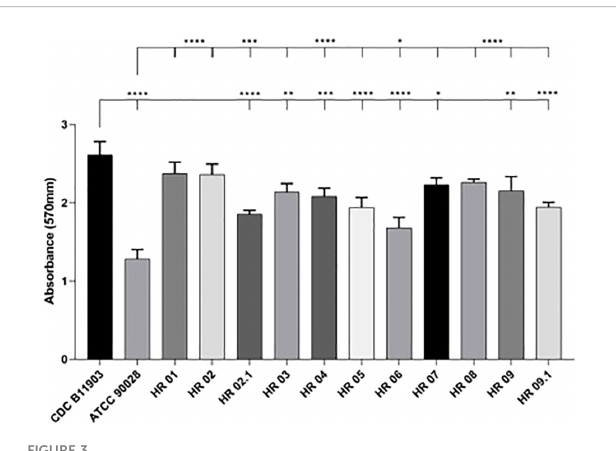
FIGURE 3 Bio fi lm formation capacity on the polystyrene surface of clinical isolates of C. auris after 24 h. One-way analysis of variance with multiple comparisons by Tukey ’ s post hoc test was used to determine statistical signi fi cance. The values of p < 0.05 were considered signi fi cant: *<0.05; **<0.01; ***<0.001;